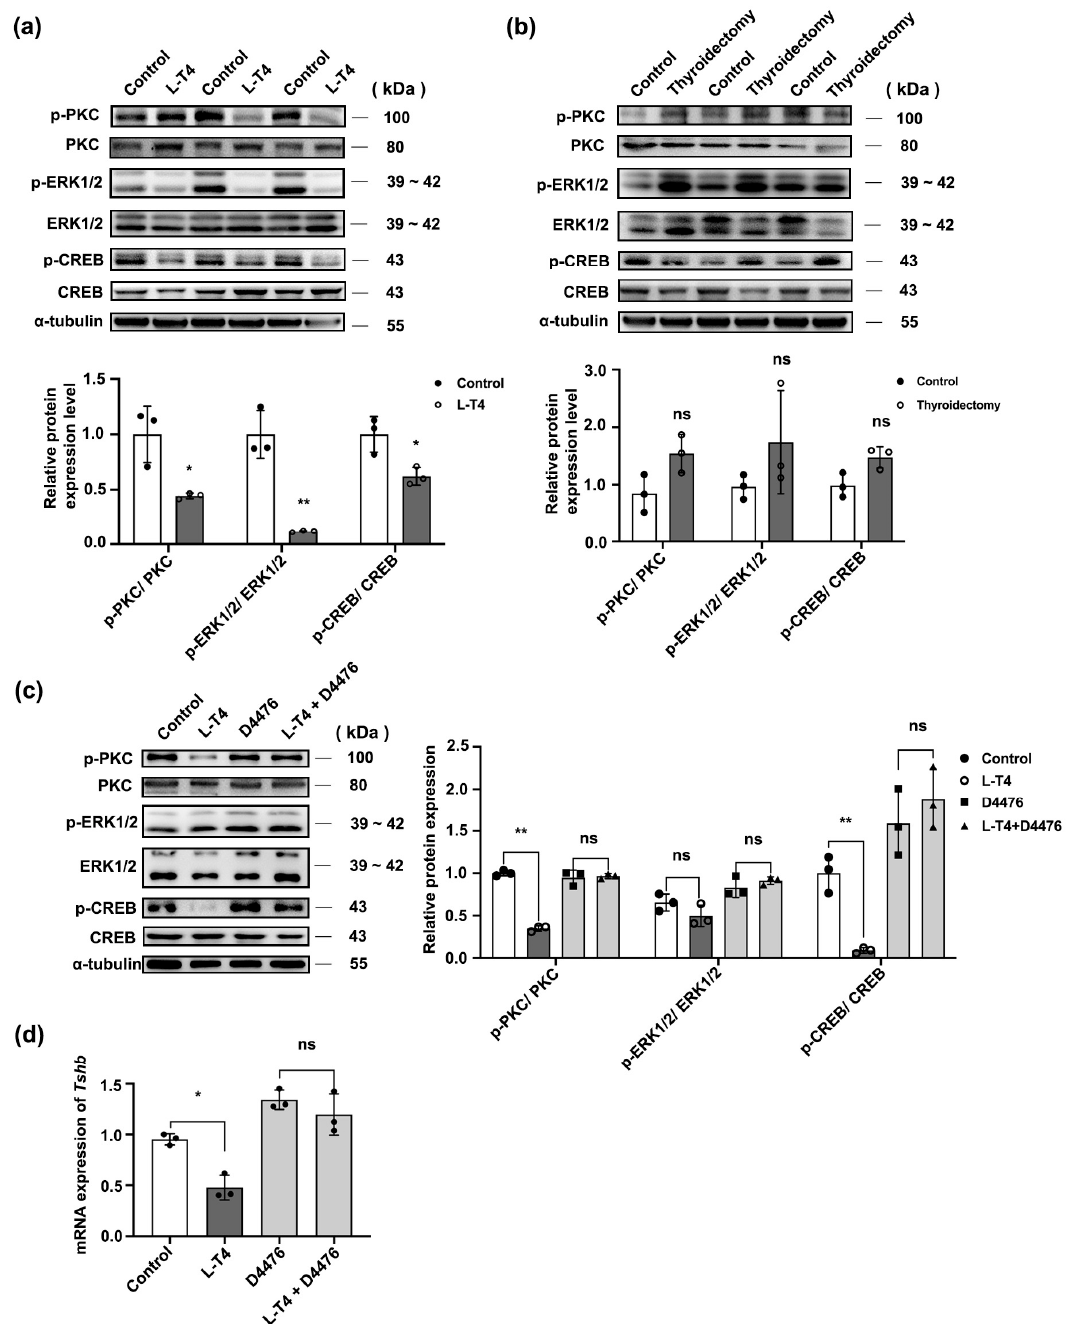
Figure 7. CK1 α mediates the e ff ect of the L-T4 signaling pathway on TSH synthesis. ( a , b ) In the L- T4 and thyroidectomy groups, p-PKC, p-ERK1/2, p-CREB, PKC, ERK1/2, and CREB abundance was determined using Western blo tt ing; p-PKC, p-ERK1/2, and p-CREB were normalized to total PKC, ERK1/2, and CREB, respectively. * p < 0.05, ** p < 0.01 and ns = no signi fi cant, n = 3. ( c , d ) In vitro, pituitary cells were treated with D4476 and then with 10 µM L-T4 for 30 min; the Tshb transcriptional level was quanti fi ed using RT-PCR, and p-PKC, p-ERK1/2, p-CREB, ERK1/2, and CREB abundance was determined using Western blo tt ing; PKC, ERK1/2, and CREB were used as the internal refer- ence. * p < 0.05, ** p < 0.01 and ns = no signi fi cant, n = 3. Each experiment was independently repeated three times.